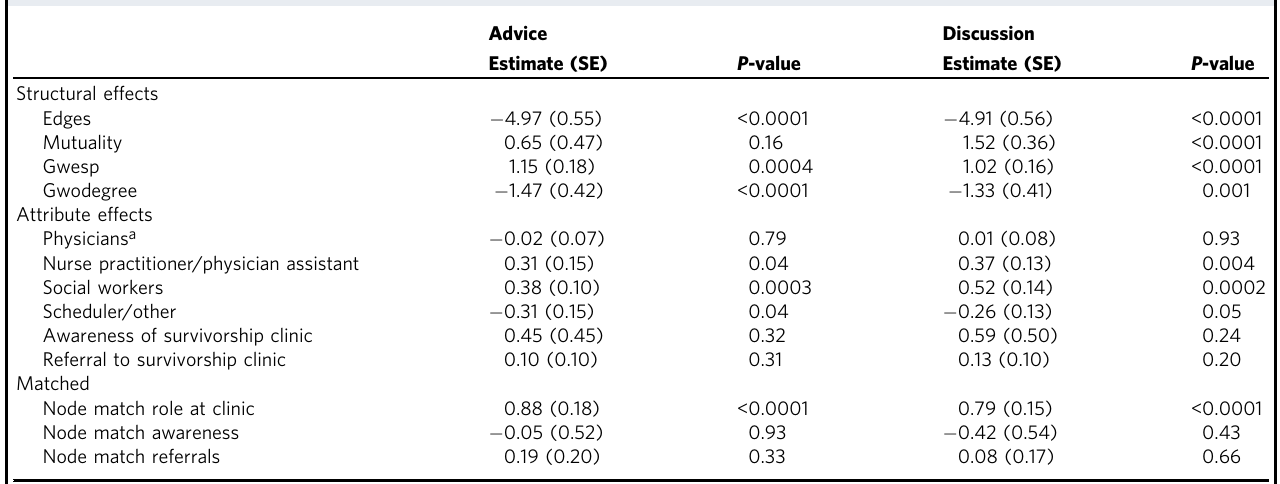
Table 2 Exponential random graph models for advice and discussion networks.